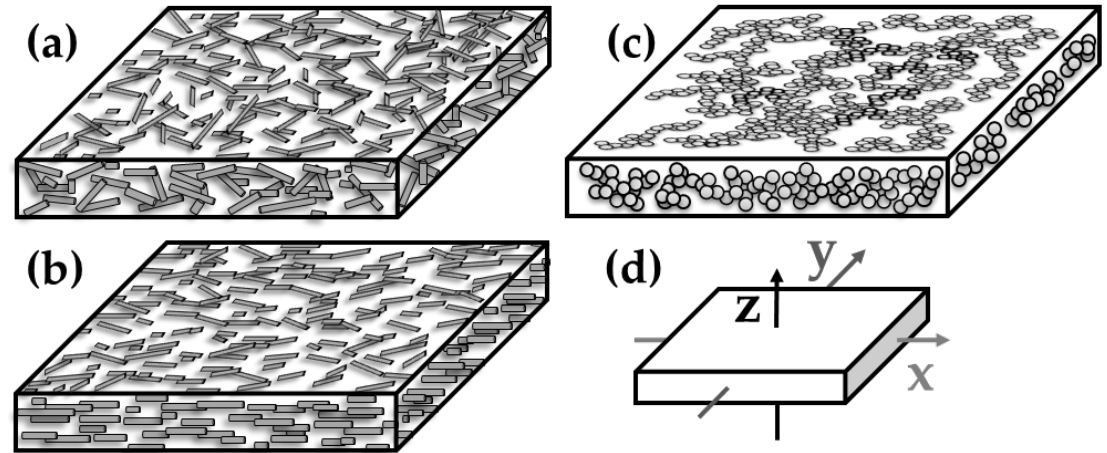
Figure 12. Schemes of filler orientation: ( a ) CNTs in compression molded plates, ( b ) CNTs in extruded films in extrusion direction x, ( c ) CB in plates and films, ( d ) schema of measurement directions for films: z= through-plane; x = in-plane, || to the extrusion direction; y = in-plane, ⊥ to extrusion direction.